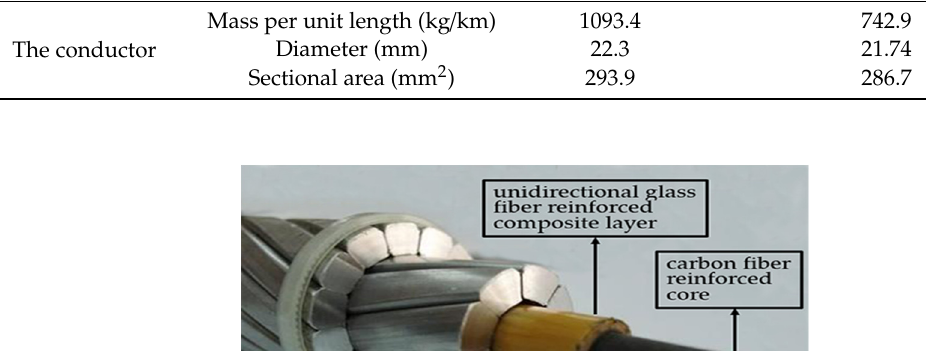
Table 2. Main structural parameters of ACCC/HW and ACSR of the similar specification.